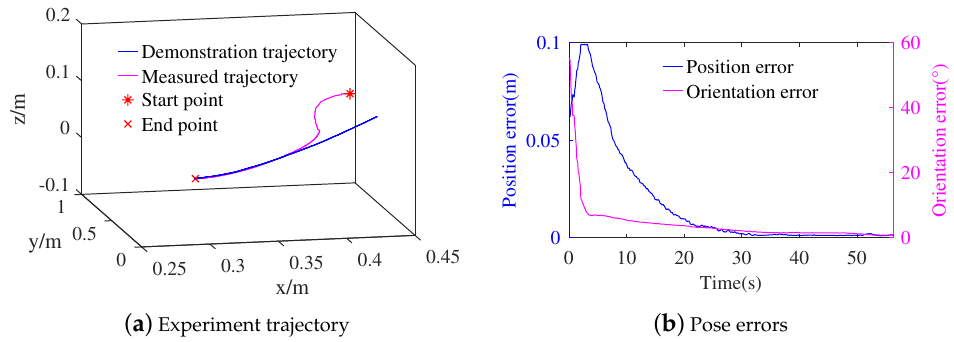
Figure 12. Experiment trajectory and pose errors of robot moving from the free space under no interactions.